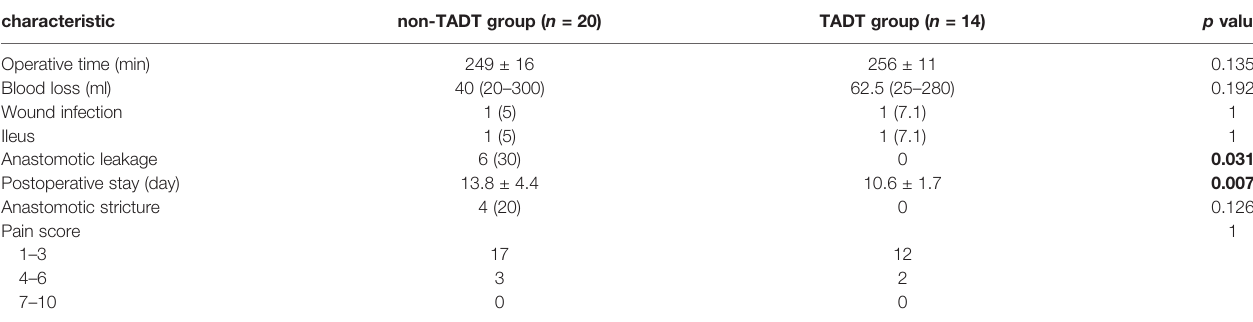
TABLE 2 | Short-term results (n =